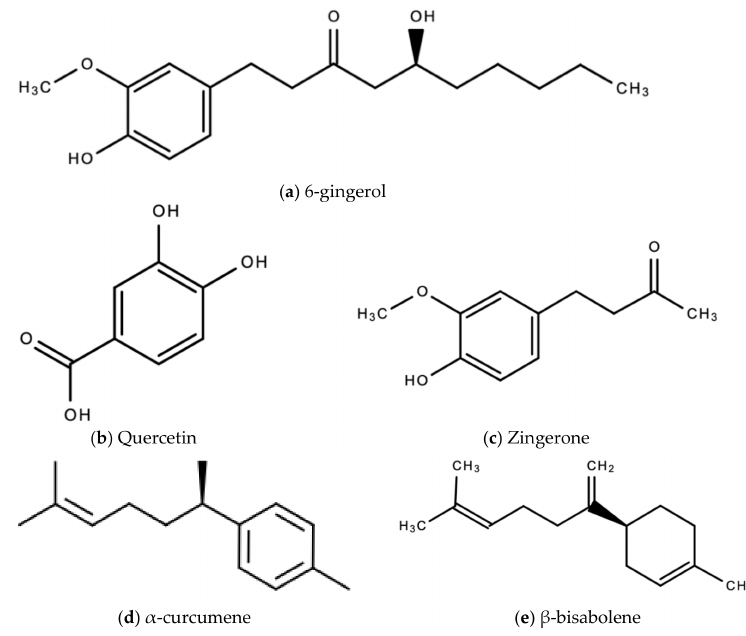
Figure 8. Chemical structures of some bioactive molecules found in Zingiber officinale Roscoe.